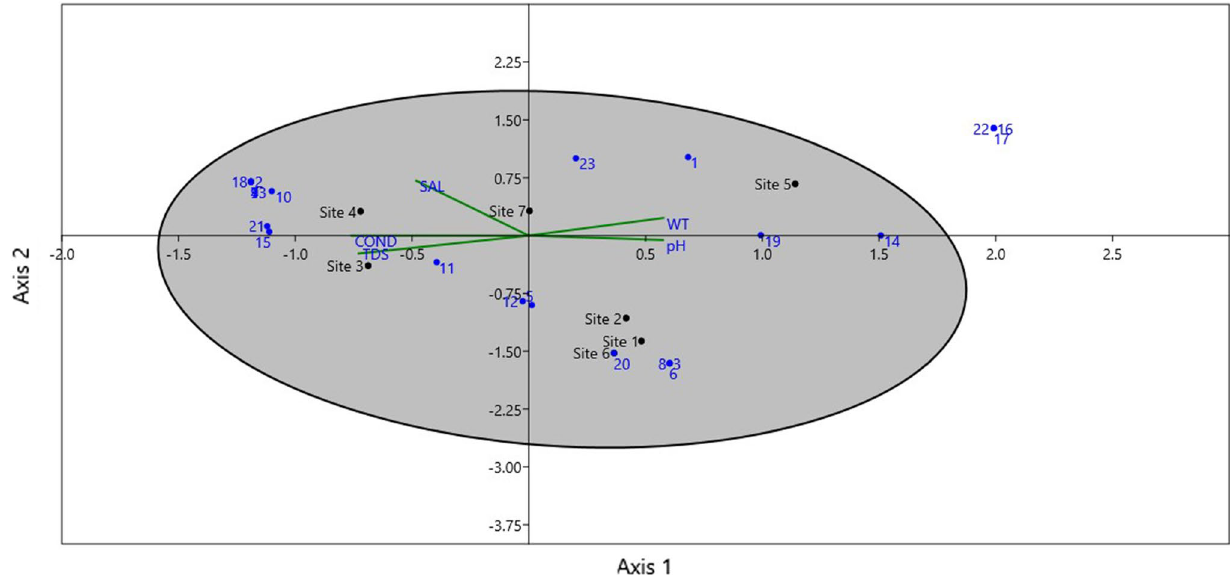
Fig. 6 Canonical correspondence analysis (CCA) ordination dia- gram showing scatter plot for selected phytoplankton, environmental variables and seven study sites. Vector lines represent the relation- ship of significant environmental variables to the ordination axes; their length is proportional to their relative significance. (1 = Ana- baena circinalis , 2 = Ankistrodesmus falcatus , 3 = Chlorella vulgaris , 4 = Chroococcus limneticus , 5 = Closterium parvulum , 6 = Dimorpho-